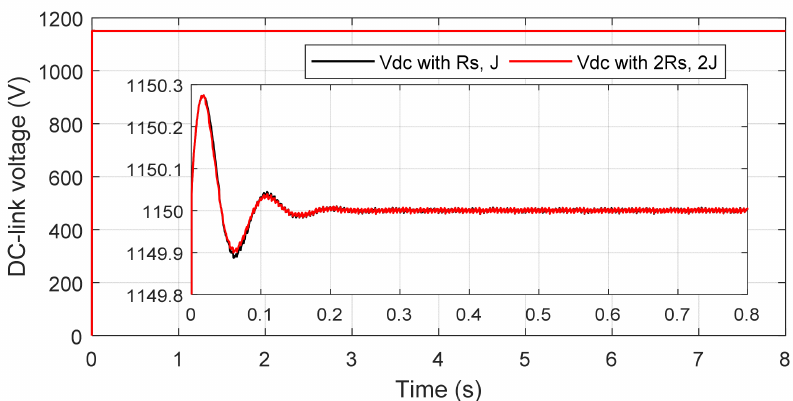
Figure 14. DC-link with parameter changes.